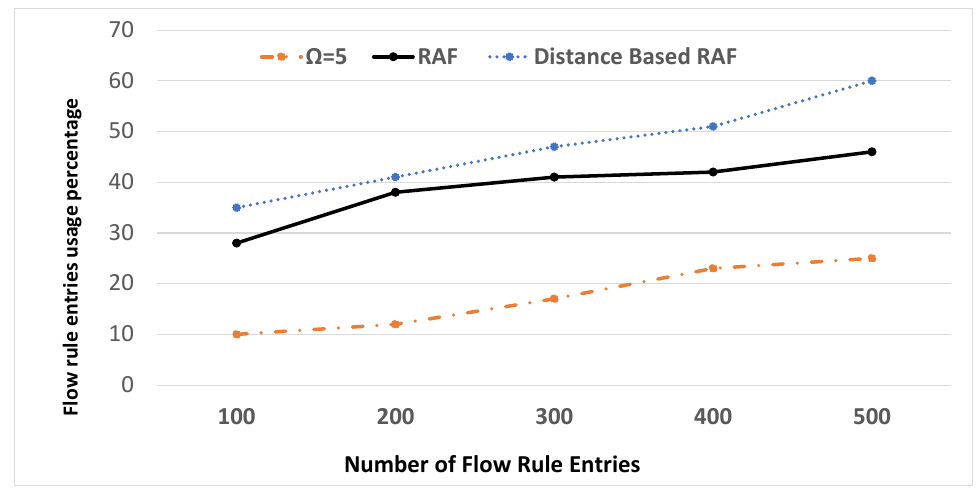
Figure 9. Flow rule entries processing the production packets according to specified action in a flow rule